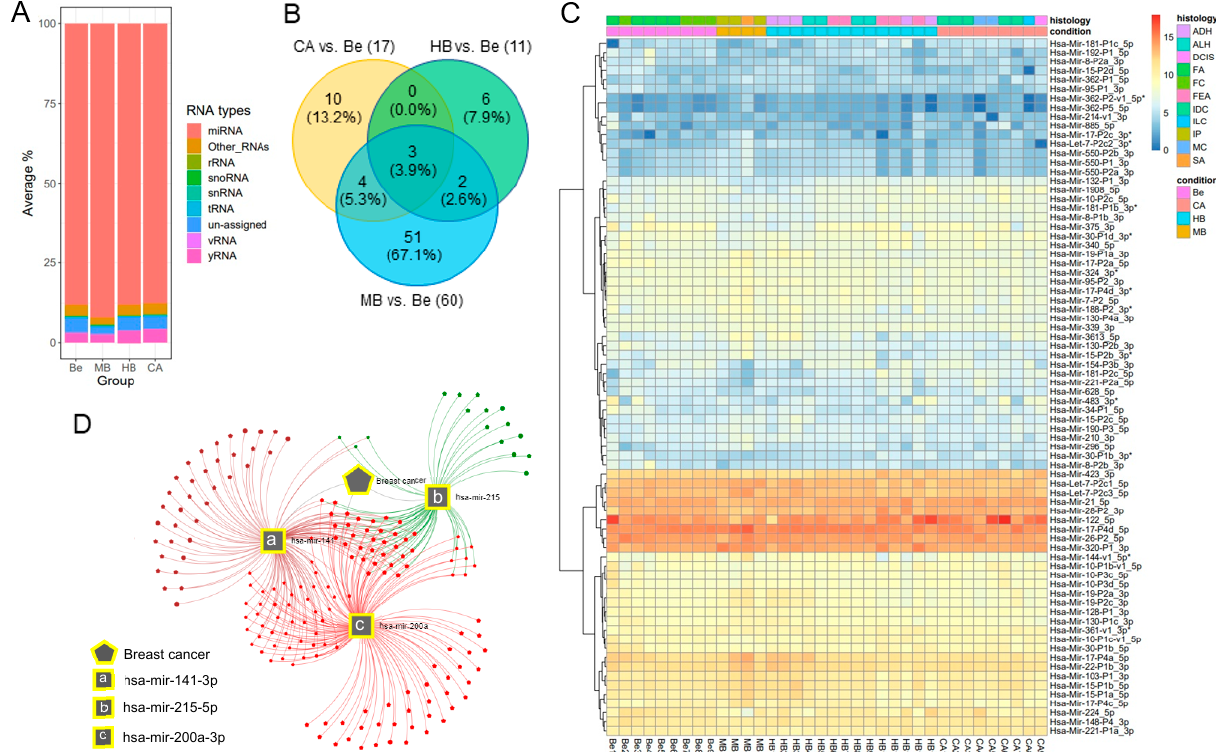
Figure 1. Plasma small RNA profiling. ( A ) Stacked bar plot shows the distribution of RNA species based on the percentage of mapped reads in each group. ( B ) Venn diagram represents the number of differentially expressed miRNAs in CA vs. Be, HB vs. Be, and MB vs. Be. A total of 76 miRNAs were differentially expressed in at least one comparison, while three of them were common in all. ( C ) Heatmap of the 76 differentially expressed miRNAs. ( D ) The miRNA-disease target network highlighted that three overlapped miRNAs were associated with breast